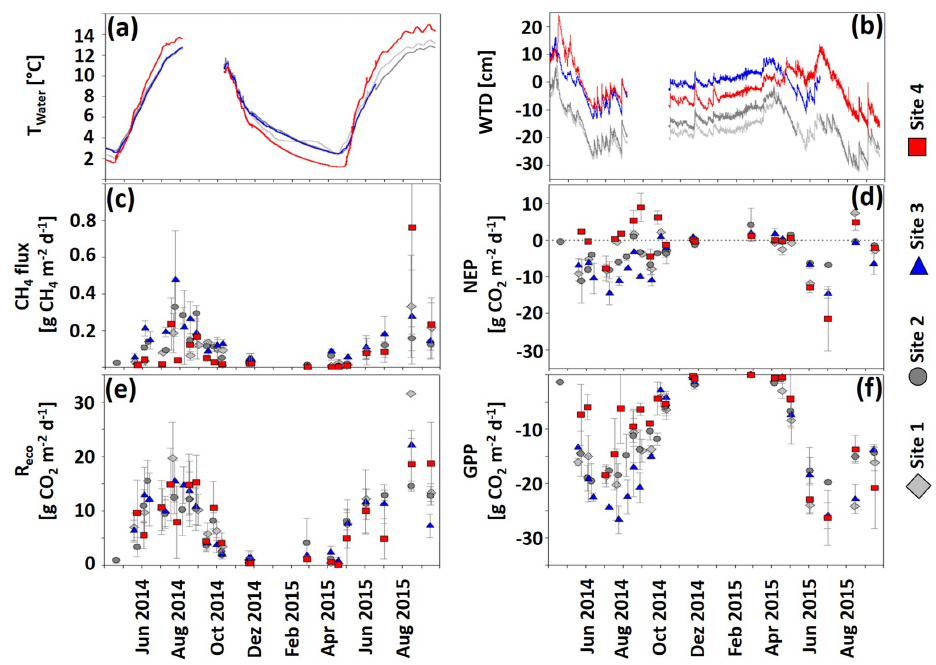
Figure 3. Development of (a) T water ( ◦ C), (b) WTD (cm), (c) CH 4 fluxes (gCH 4 m − 2 d − 1 ), and (d–f) CO 2 fluxes (NEP partitioned into R eco and GPP; gCO 2 m − 2 d − 1 ) ± 1 SD ( n = 6) in hollows at sites 1–4 from 1 April 2014 through 22 September 2015. Negative CO 2 and CH 4 fluxes indicate uptake, and positive fluxes indicate a release to the atmosphere. The dashed gray line in the NEP graph indicates a 0 flux.